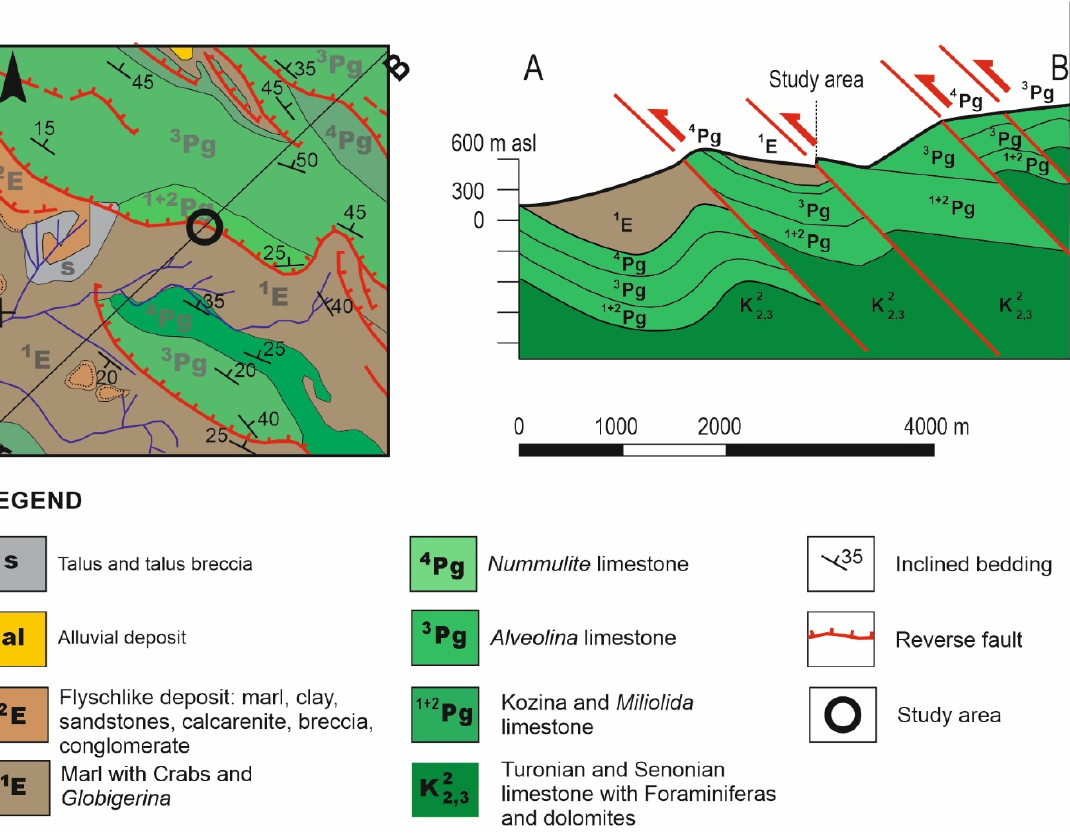
Figure 3. Geological map of the wider area of the Raspadalica Cliff: Geological map ( left ) and geological cross-section ( right ). Black circle indicates the Raspadalica Cliff location [8,9].